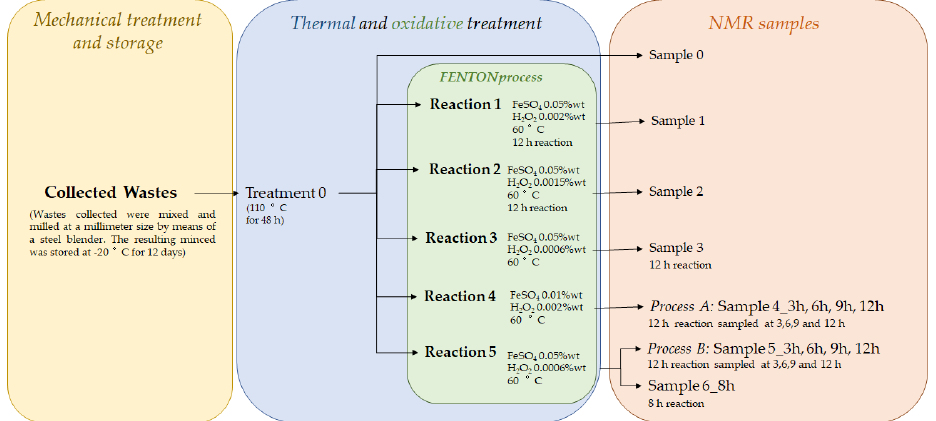
Figure 1. Experimental steps, oxidative reaction conditions, and NMR samples collected for each process the initial sample of the organic fraction of municipal solid waste (OFMSW) was subjected to.